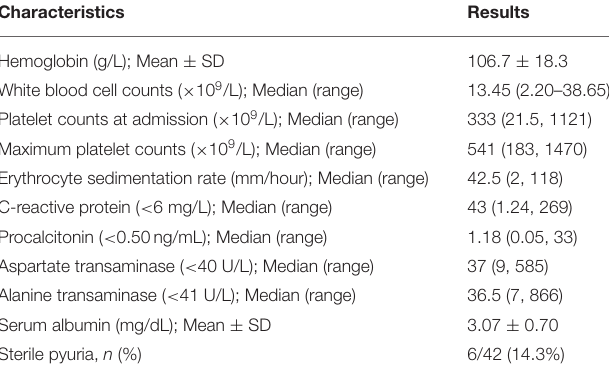
FIGURE 1 | Trends of diagnosis of Kawasaki disease in children aged 10 years or older in Chandigarh, India (1994–2019) [x axis shows years and y axis shows number of